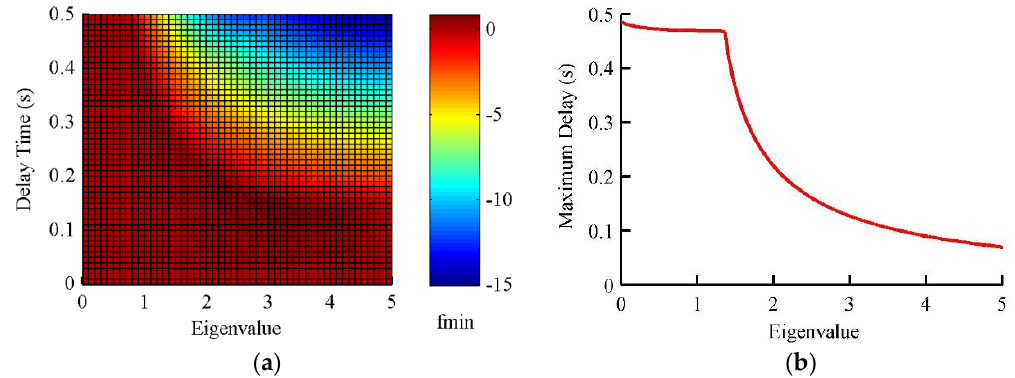
The numerical analysis results are shown in Figure 4.